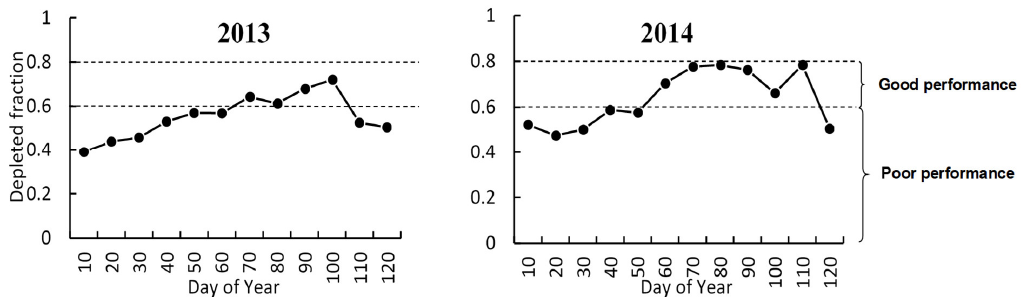
Figure 8. Variations of depleted fractions across the Kou Valley irrigation scheme during the dry season periods in 2013 and 2014. The thresholds for distinguishing between poor and good performance are indicated by the dashed lines.